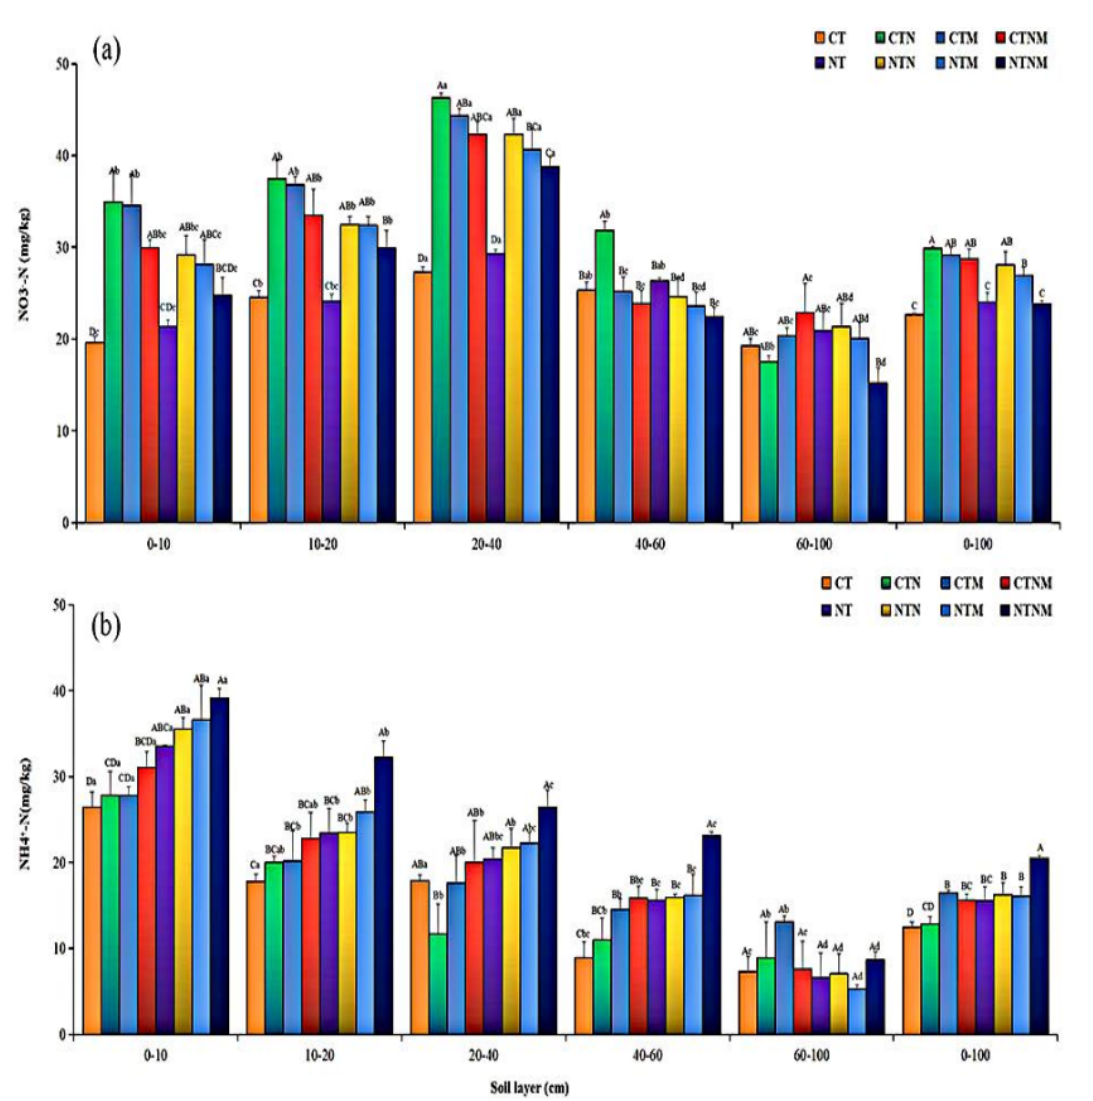
Figure 4. Effect of tillage techniques and N fertilization methods on mineral N. Note: ( a ) is the concentration of NO 3 − -N at different soil layers; ( b ) is the concentration of NH 4+ -N at different soil layers. The error bars indicate standard deviation. Different capital letters indicate significant differences between different treatments for the same soil layer ( p < 0.05; Duncan’s test), and different lower-case letters indicate significant differences between different treatments and different soil depths ( p < 0.05; Duncan’s test). CT: conventional tillage, CTN: conventional tillage with